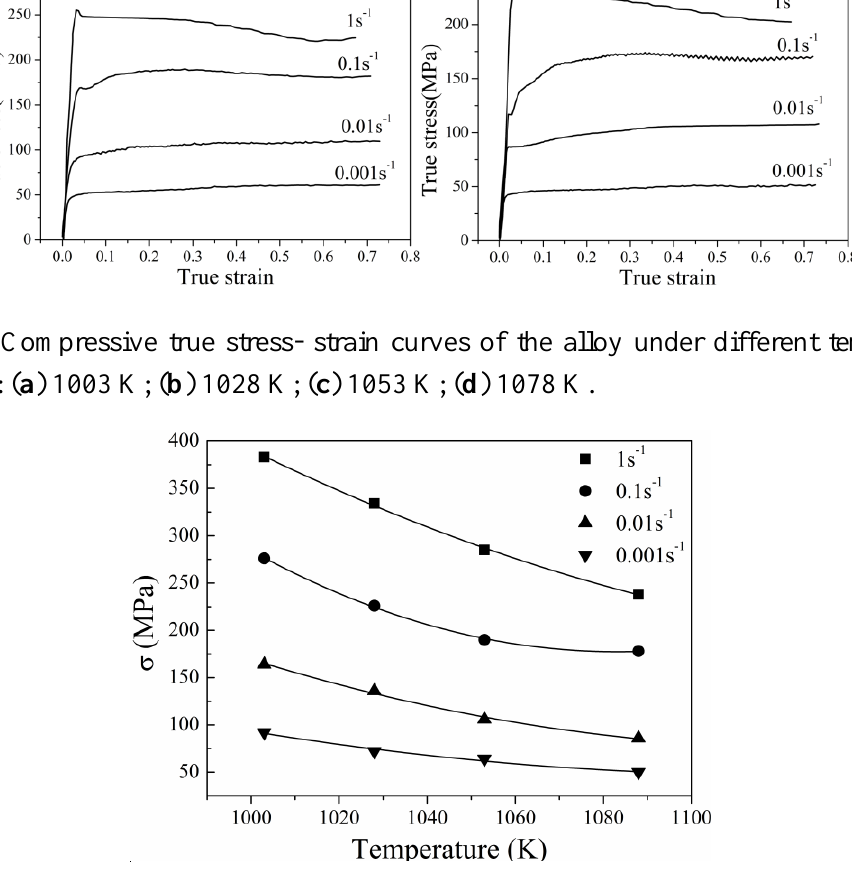
Figure 3. Effect of deformation temperature and strain rate on the peak flow